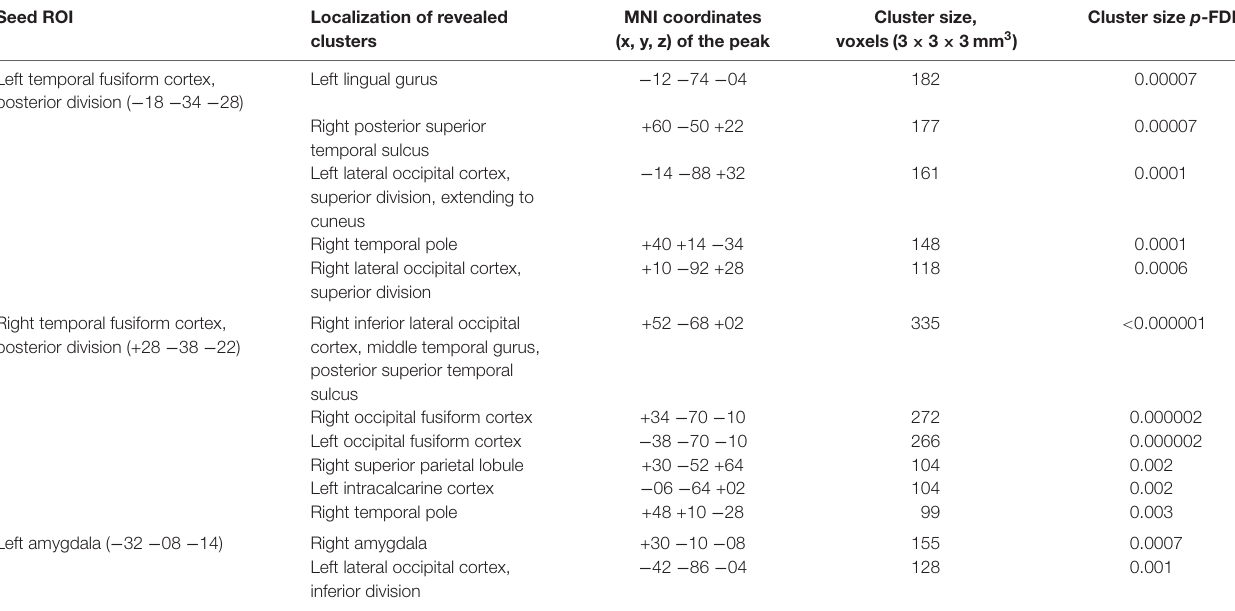
TABLE 2 | Clusters showing increased connectivity with the seed regions after neurofeedback. Seed